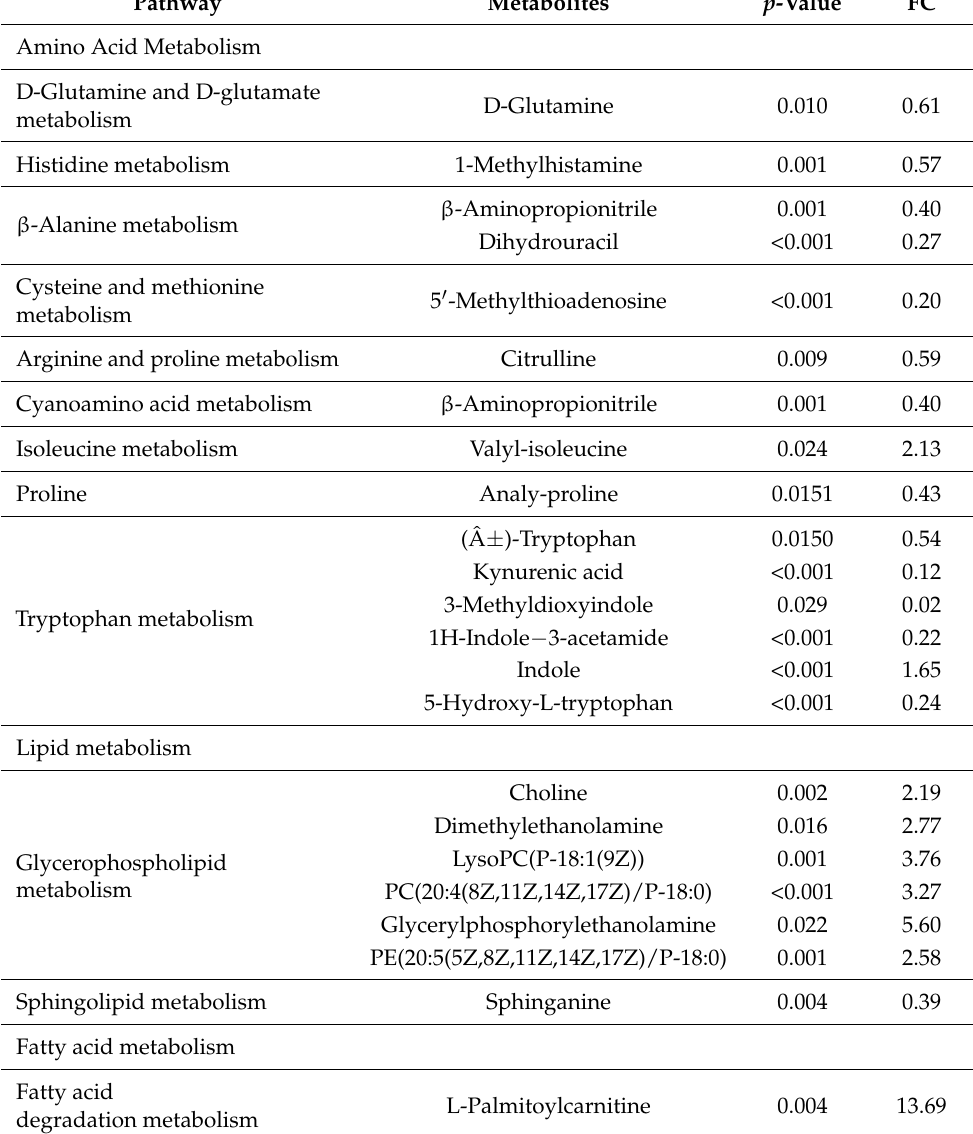
Table 2. The altered metabolic pathways and the corresponding differential metabolites in serum samples from CON and GDM